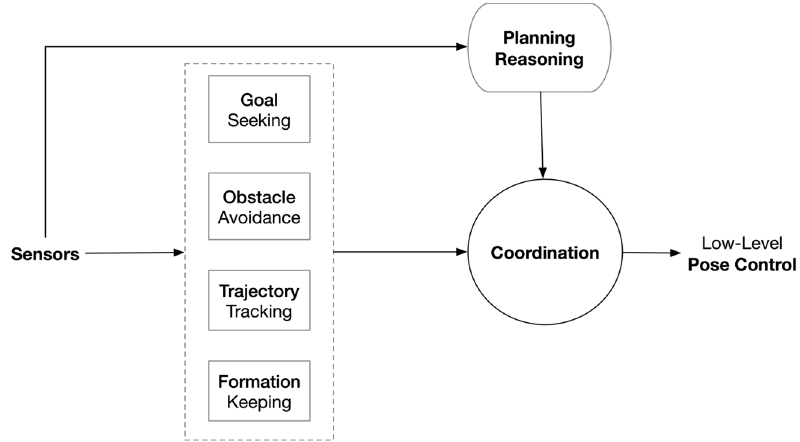
Figure 2. Architecture of high ‐ level control vehicle.